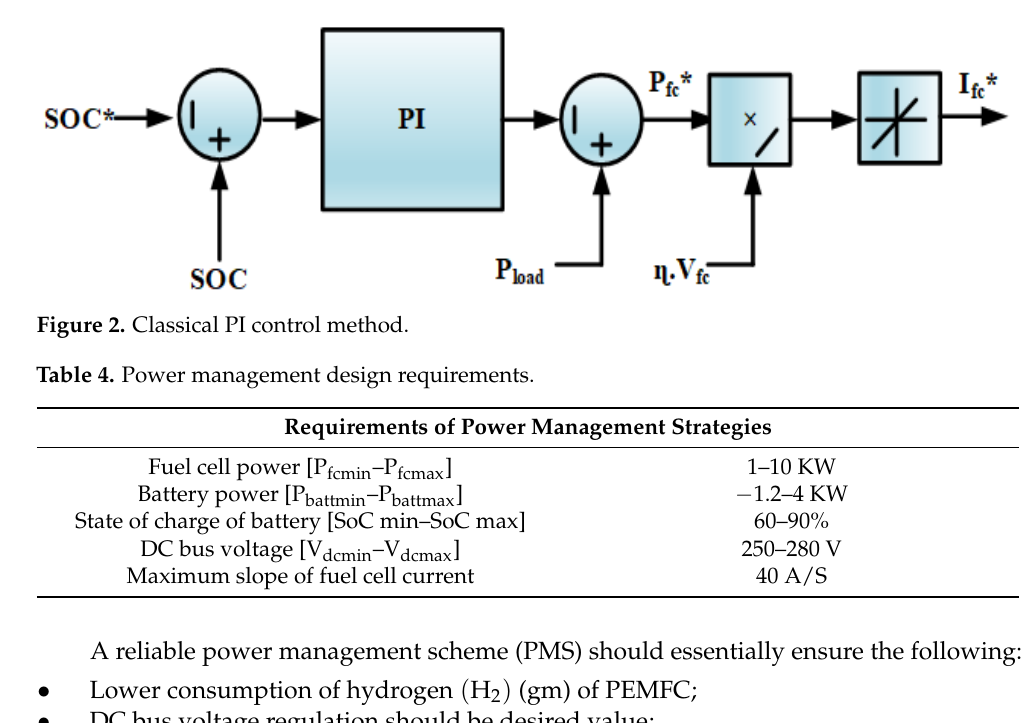
Table 4. Power management design requirements.